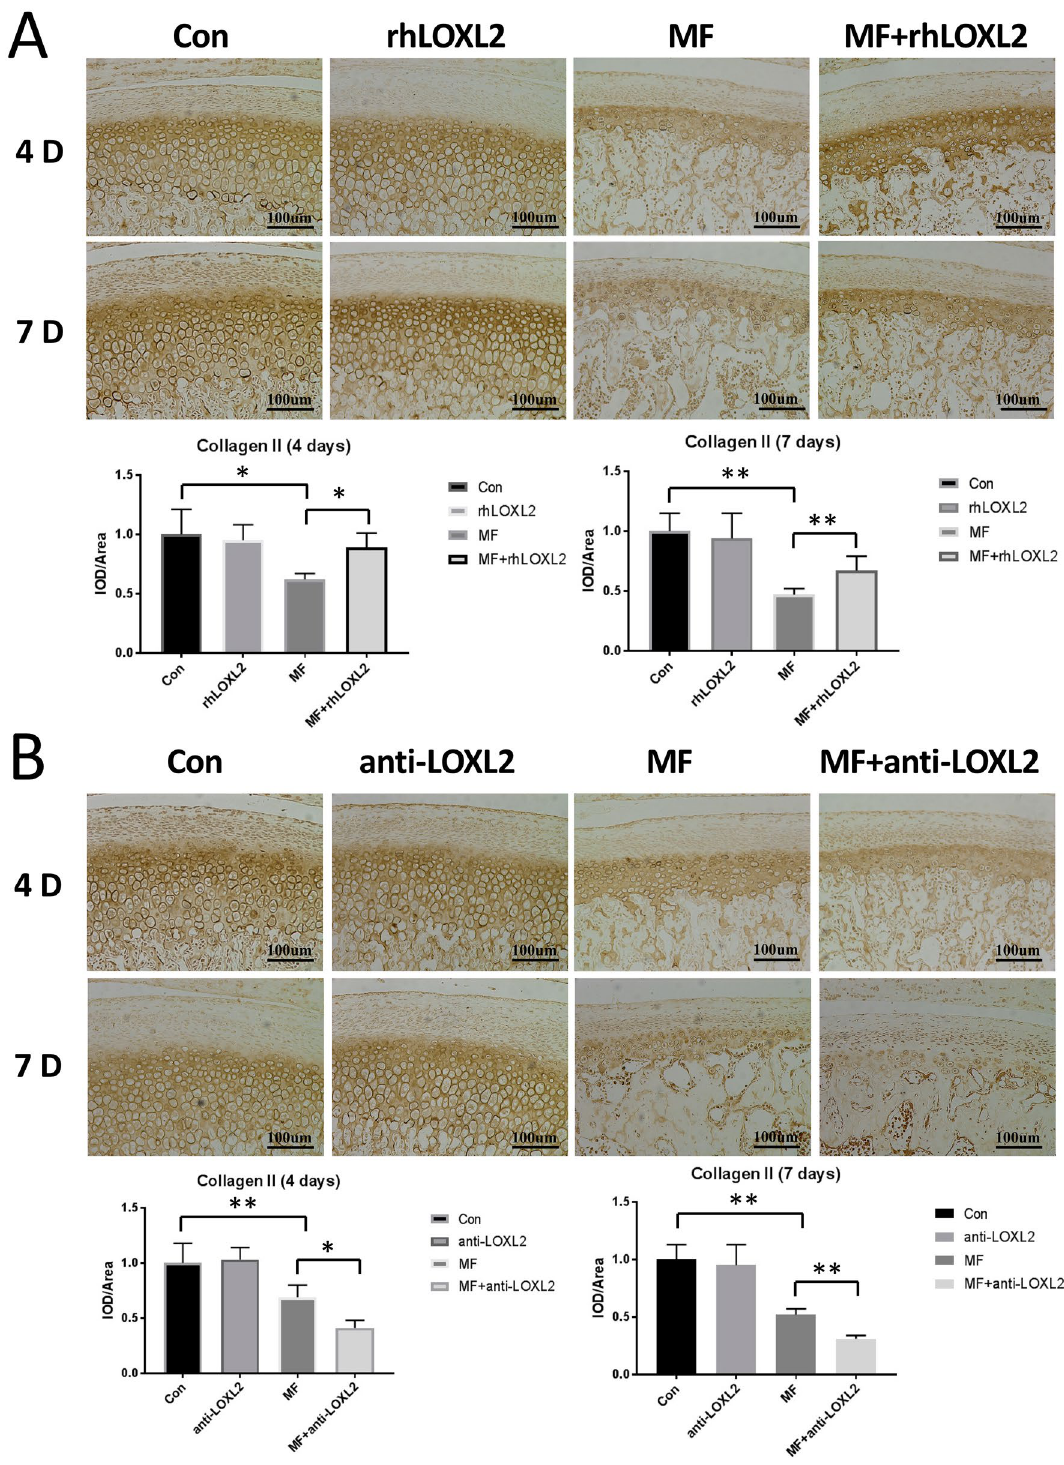
Figure 4. LOXL2 restored collagen II degradation in mandibular condyle cartilage at 4 and 7 d after force application. Immunohistochemical analysis of Collagen II expression and quantification of it in chondrocytes from samples treated as indicated (n = 12). ( A ) Degradation of collagen II in MF groups (4-days, p < 0.05; 7-days, p < 0.01; compared with the controls) was recovered by rhLOXL2(4-days, p < 0.05; 7-days, p < 0.01; compared with the MF groups), ( B ) while worsened by anti-LOXL2(4-days, p < 0.05; 7-days, p < 0.01; compared with the MF